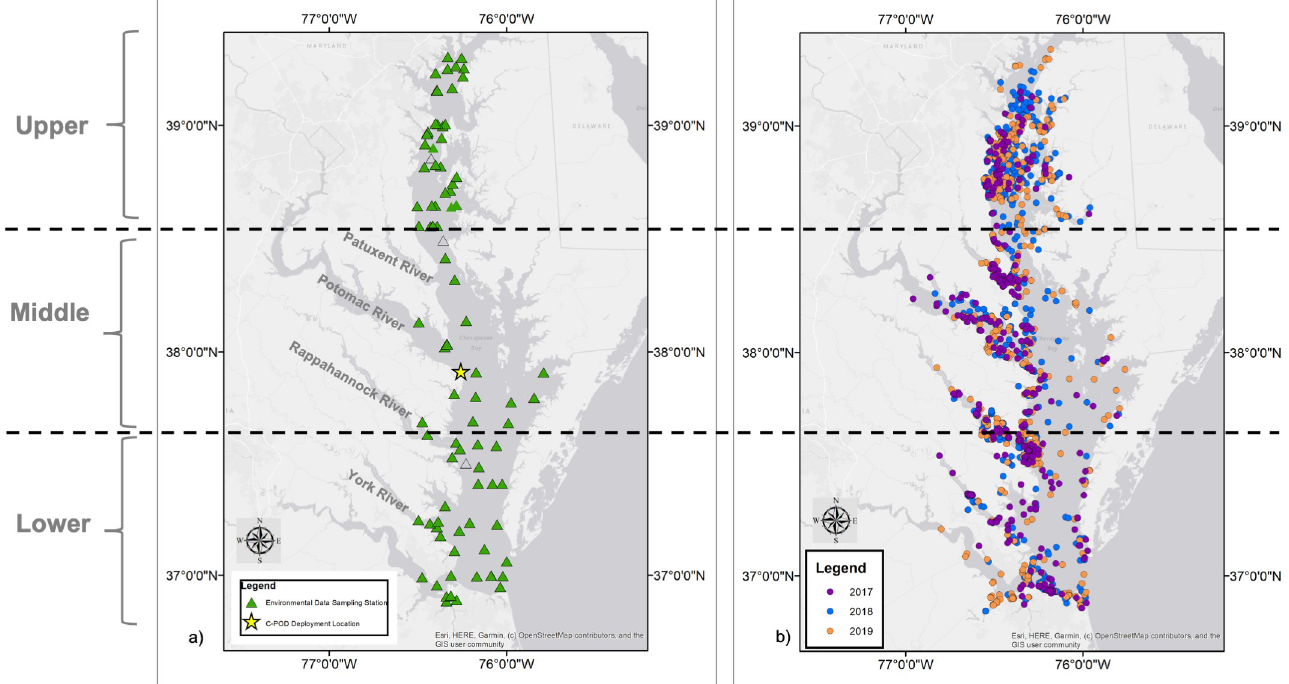
Fig 1. Spatial distribution of study data. a) The Chesapeake Bay study area, which we divided into three latitudinally-equal segments with the Lower Bay segment being closest to the Atlantic Ocean. The location of the C-POD passive acoustic monitoring device (yellow star) and locations of environmental data sampling stations (green triangles) are shown on the map. b) Spatial distribution of non-duplicated, confirmed bottlenose dolphin sighting reports from the Chesapeake DolphinWatch citizen science project. Map attribution: ESRI, HERE, Garmin, OpenStreet Map.